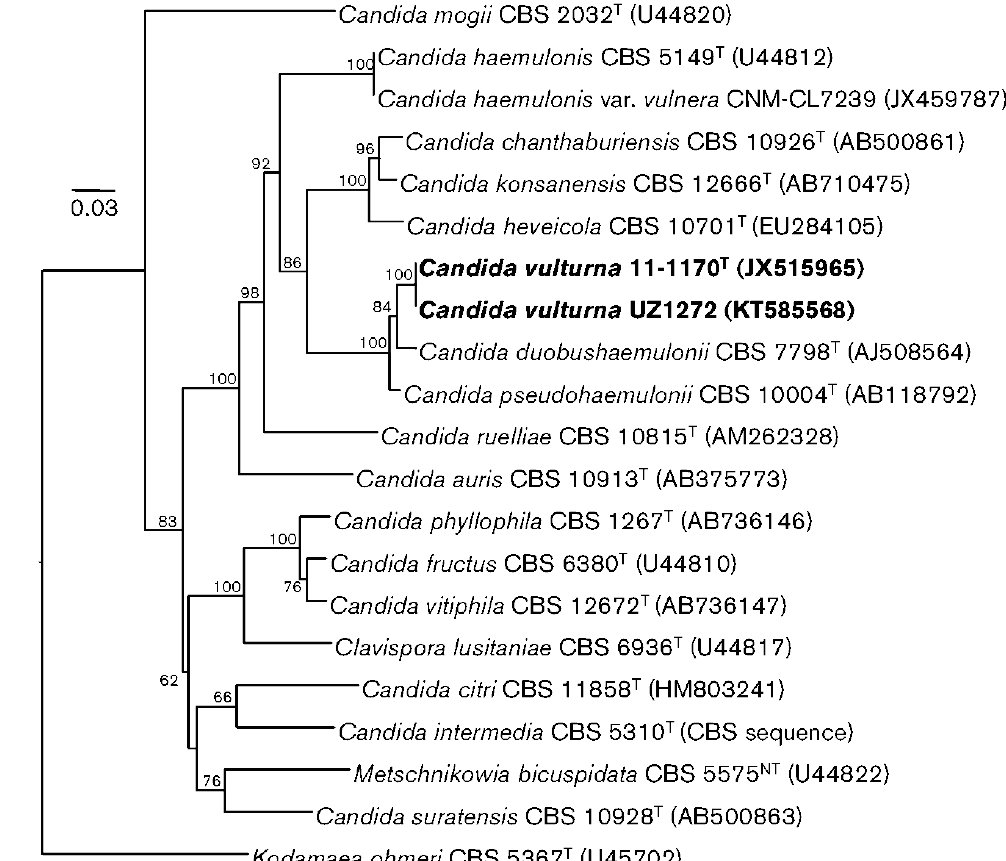
Figure 1. Phylogenetic relationships of Candida auris with Candida vulturna strains (in bold from original publication) and other related species and genera determined from a neighbor-joining analysis of sequences of the D1/D2 domains of the LSU rRNA genes. The sequence of the type strain of Kodamaea ohmeri was the outgroup in the analysis. Bootstrap values are given at branch nodes. Bar, 0.03 changes per position. Reproduced with permission from Sipiczki M and Tap RM, Candida vulturna pro tempore sp. nov., a dimorphic yeast species related to the Candida haemulonis species complex isolated from flowers and clinical sample; published by Microbiology Society, 2016 [57].